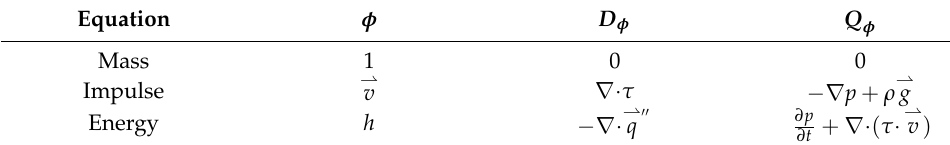
Table 4. Specifications of the prototypical conservation equation